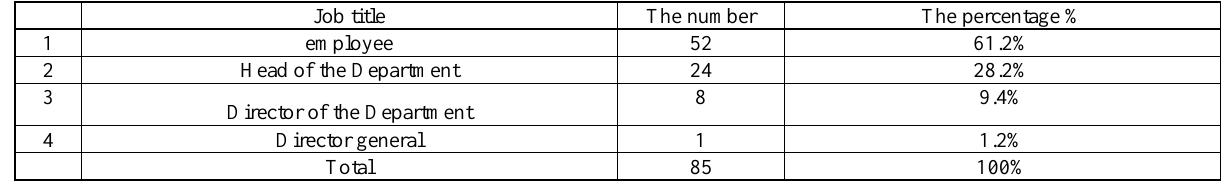
Table 5. Distribution of members of the study sample according to the job